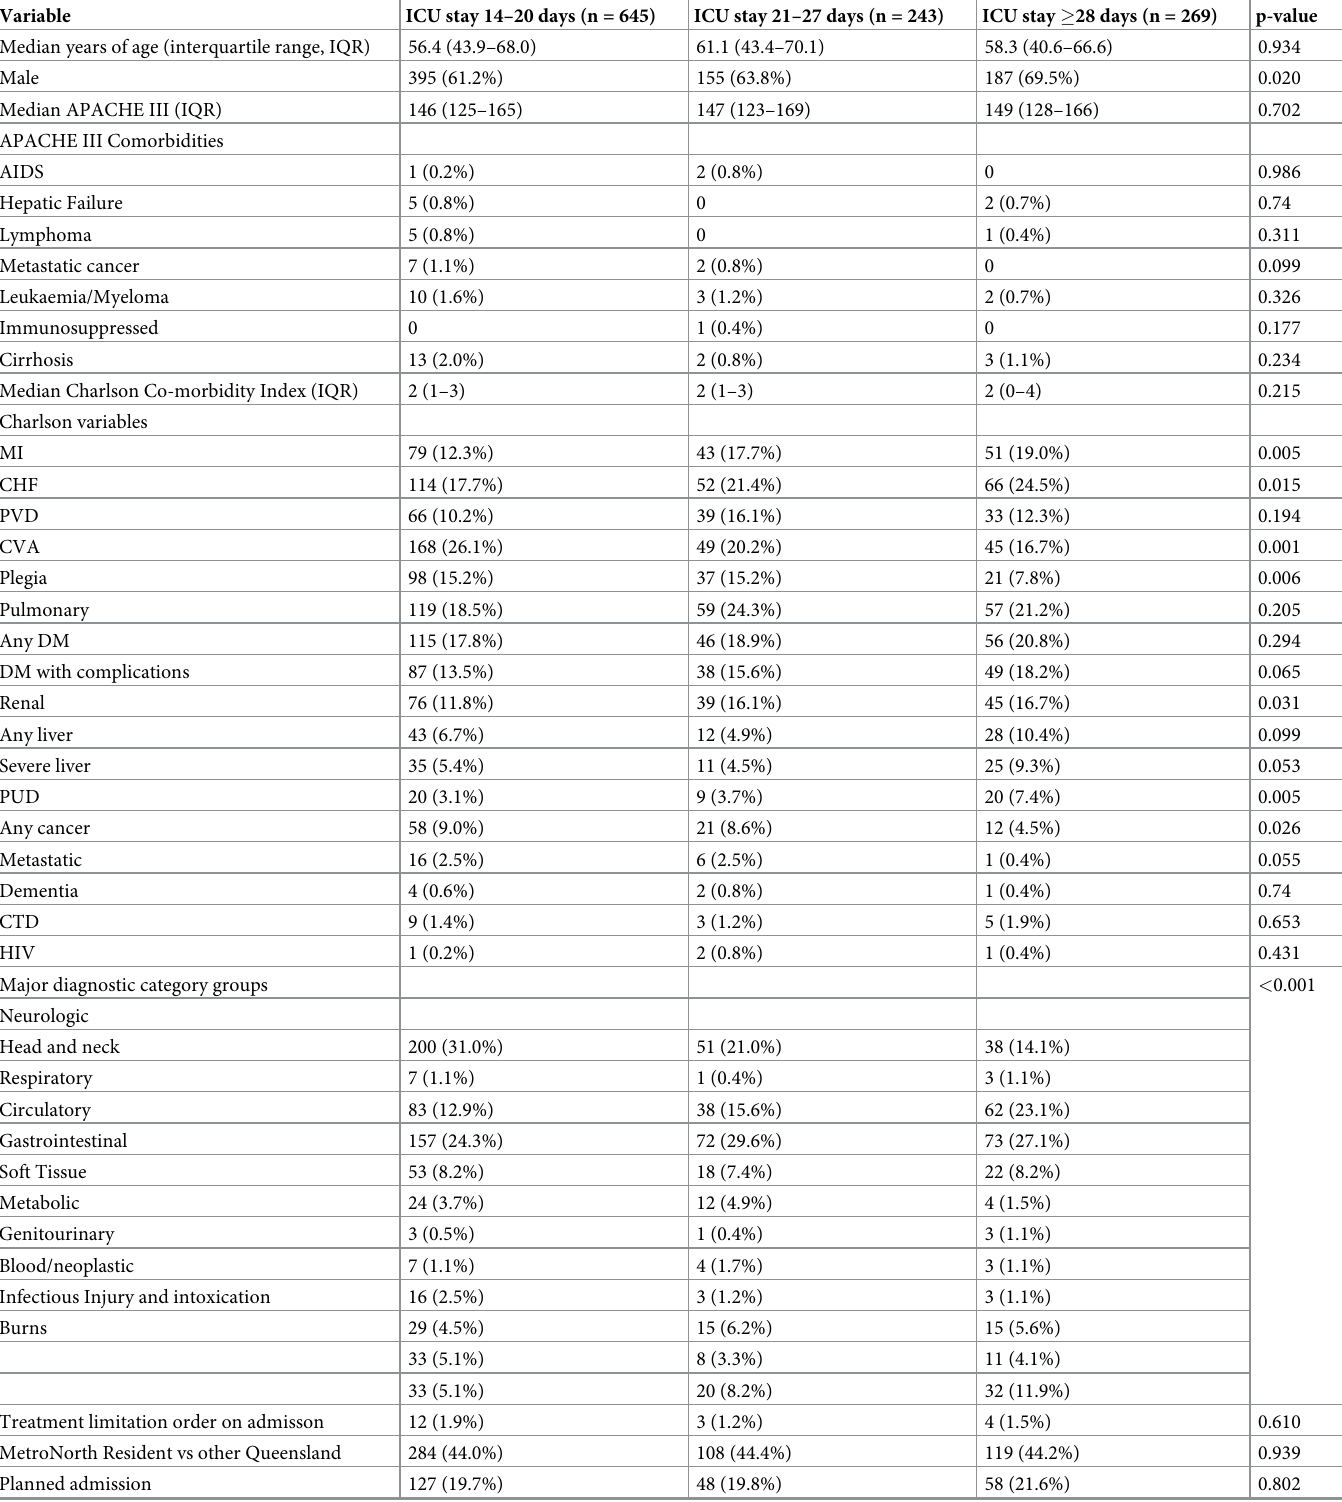
Table 1. Admission characteristics of patients with prolonged admission to